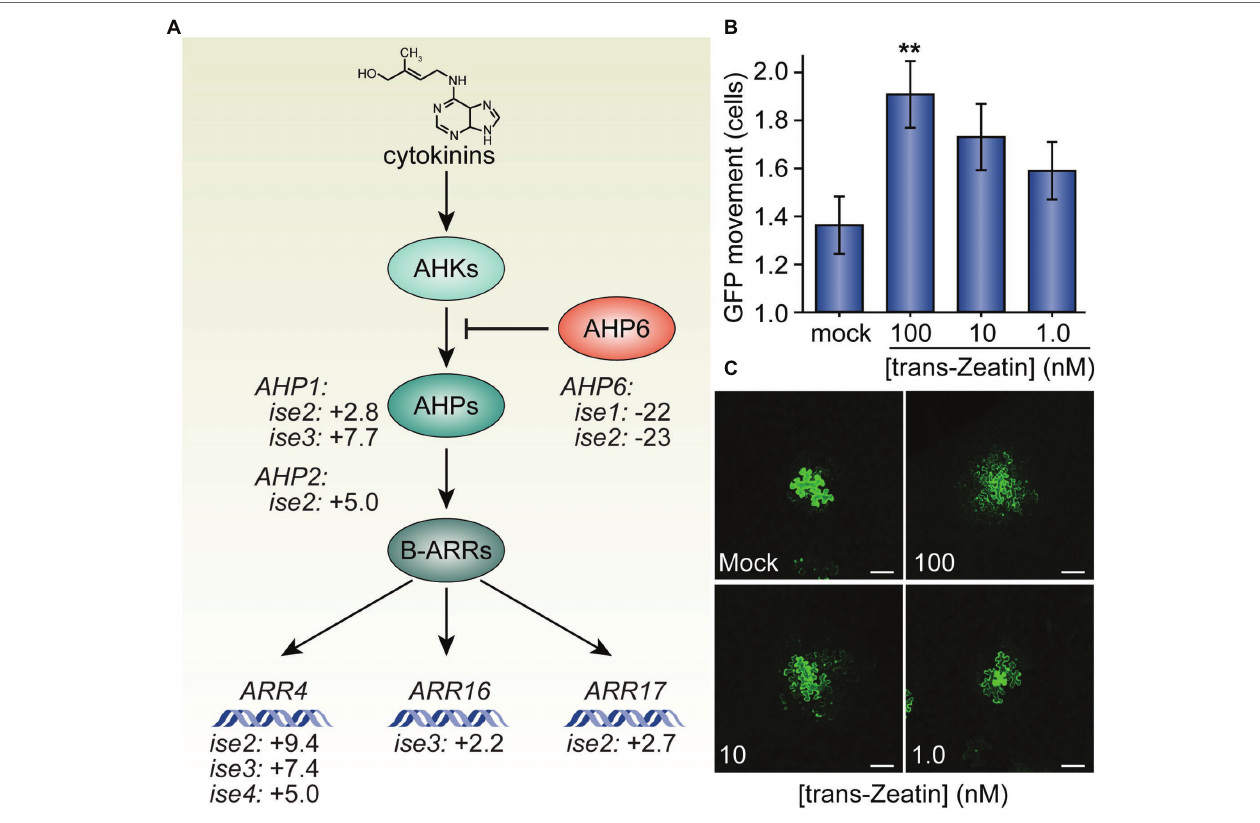
FIGURE 1 | Trans -Zeatin (cytokinin) stimulates plasmodesmata (PD)-mediated green fluorescent protein (GFP) movement in Nicotiana benthamiana leaves. (A) Cytokinins (e.g., trans -Zeatin, whose structure is shown) stimulate the cytokinin receptors, ARABIDOPSIS HISTIDINE KINASES ( AHK s, light teal), to phosphorylate ARABIDOPSIS HISTIDINE PHOSPHOTRANSFER PROTEINS ( AHP s, teal), which transfer phosphorylation to B-class ARABIDOPSIS RESPONSE REGULATORS ( ARR s, dark teal), which then promote transcription of cytokinin response genes, including the A-type ARR genes, ARR4 , ARR16 , and ARR17 . AHP6 (orange) acts as a decoy AHP , preventing phosphorylation of AHP s and thus antagonizing cytokinin signaling. Transcriptomic analysis of four mutants with increased PD trafficking, ise1 through ise4 , revealed the induction of AHP genes that promote cytokinin signaling, induction of A-type ARR genes that indicate elevated cytokinin responses, and repression of the AHP6 gene that inhibits cytokinin signal transduction (Burch-Smith et al., 2011; Brunkard et al., 2020). Fold-changes in mRNA levels of these genes are indicated. (B) Infiltration of 100 nM solutions of trans -Zeatin significantly increased PD transport ( n = 53, ** p < 0.01; error bars indicate SEM). 10 or 1.0 nM trans -Zeatin somewhat increased PD transport, but not to statistically significant thresholds ( n = 51 or n = 56, respectively). (C) Representative confocal images of transformed N. benthamiana cells for different treatments of the trans -Zeatin show the range of GFP movement from transformed cells. In mock-treated leaves, GFP rarely moved 1–2 cells beyond the transformed cell. After applying trans -Zeatin, GFP movement tended to increase, often moving to three cells or more beyond the transformed cell in leaves treated with 100 nM trans -Zeatin. The fourth leaf from 4-week-old N. benthamiana plants was used for each experiment; white scale bars = 100 μ